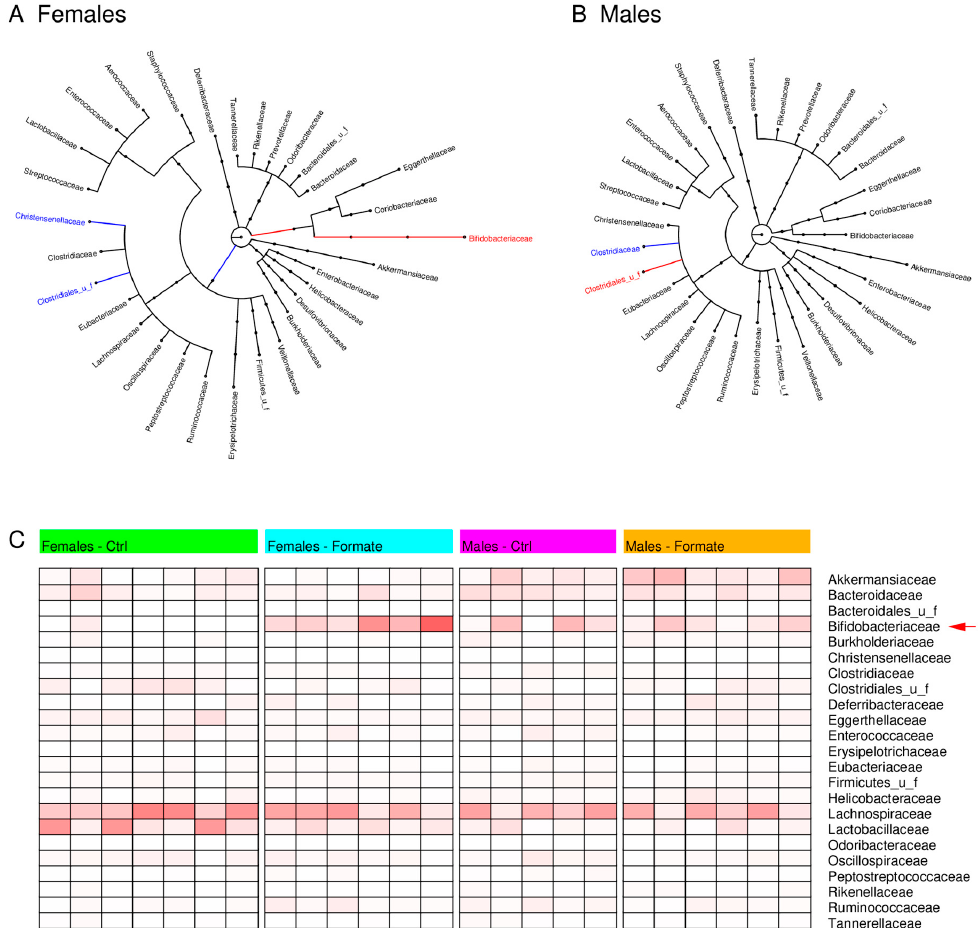
Figure 4. ( A,B ) Phylogenetic tree of the identified microbiota truncated at the family level, from the stools of female ( A ) and male ( B ) mice. The longer the edges the more significant is the difference of the microbe frequency between the cohort supplemented with 125 mM of sodium formate and controls. The red colour highlights a significant frequency increase by sodium formate supplementation and the blue colour a significant decrease. ( C ) Heatmap reporting the microbiota frequencies at the family level.